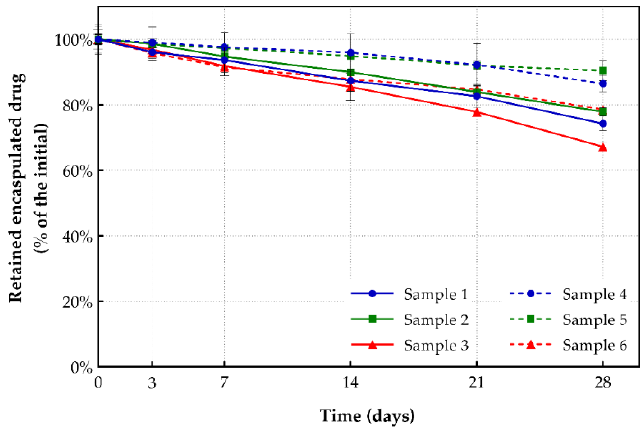
Figure 6. Drug retention of drug-loaded liposomal formulations (storage conditions: 4 °C, 28 days).